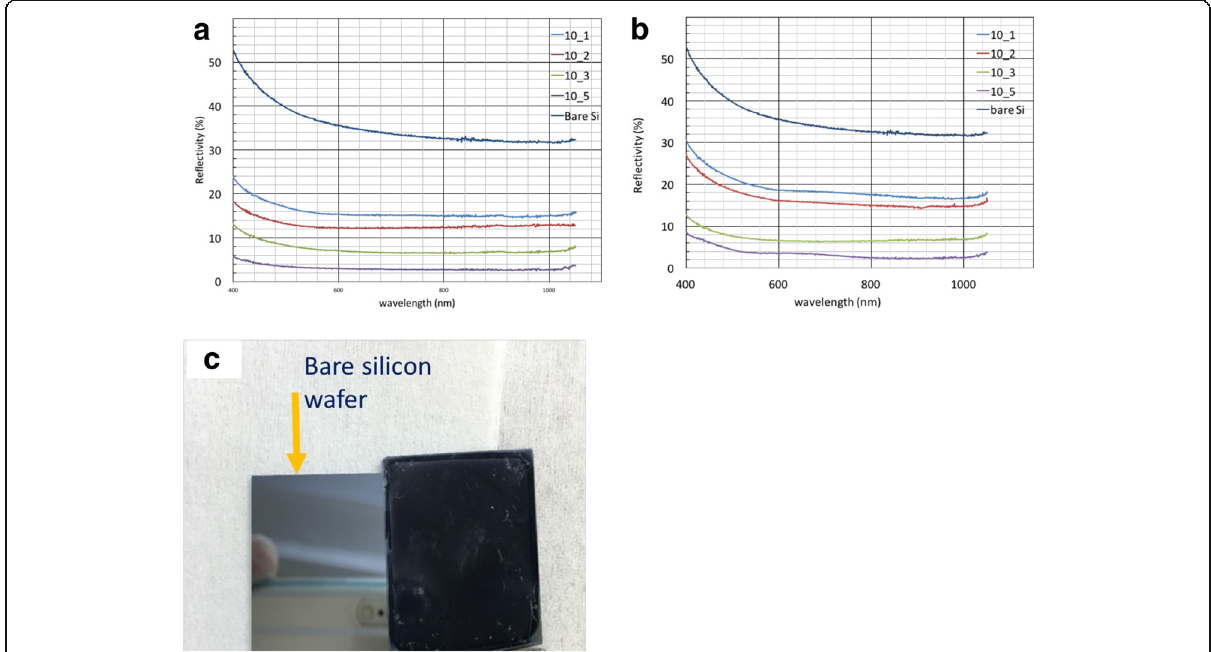
Fig. 6 Effects of surface nanostructures formed by metal salt:PMMA film on reflectivity in visible region. a Reflectivity measurement of silicon wafer having nanostructures formed by using ANN:PMMA film with different metal salt – polymer weight ratios and bare silicon wafer. b Reflectivity measurement of silicon wafer having nanostructures formed by using CNN:PMMA film with different metal salt – polymer weight ratios and bare silicon wafer. Reflectivity is reduced to 2% by using 5:10 ratio. c Photo of silicon wafers before and after surface nanostructuring. Reflectivity with respect to bare silicon wafer was drastically